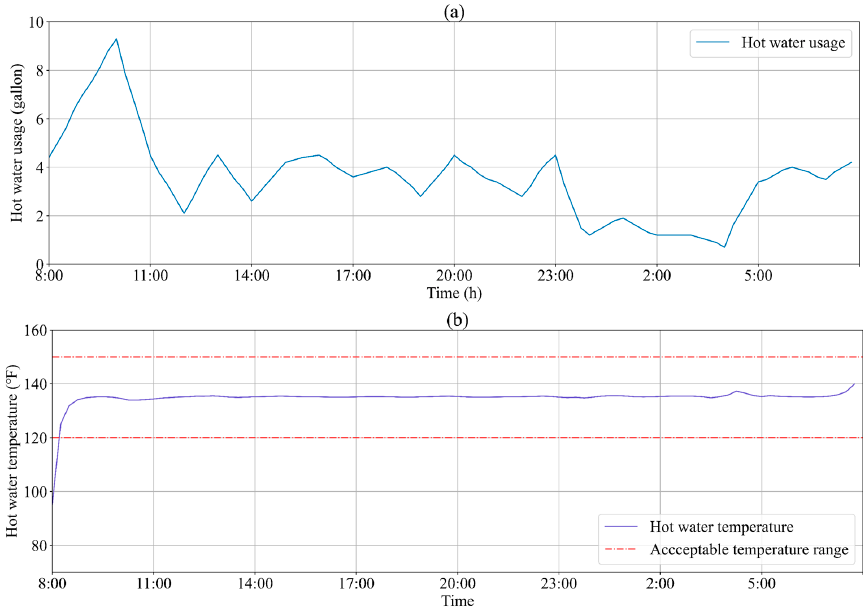
Figure 8. ( a ) Hot water usage and ( b ) scheduling results of the electric water heater considering thermal comfort of the residents.